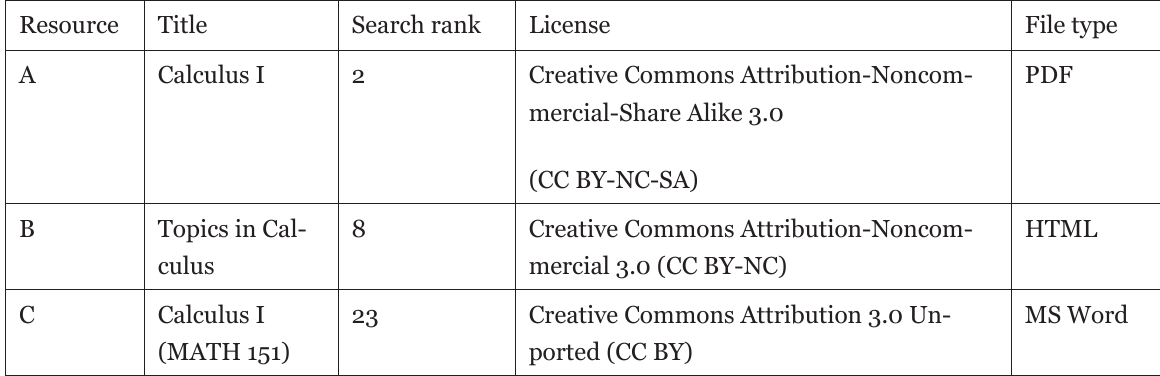
Selected Search Results at Postsecondary Level Returned by the OER Commons Search Mechanism for the Search Term Calculus Resource